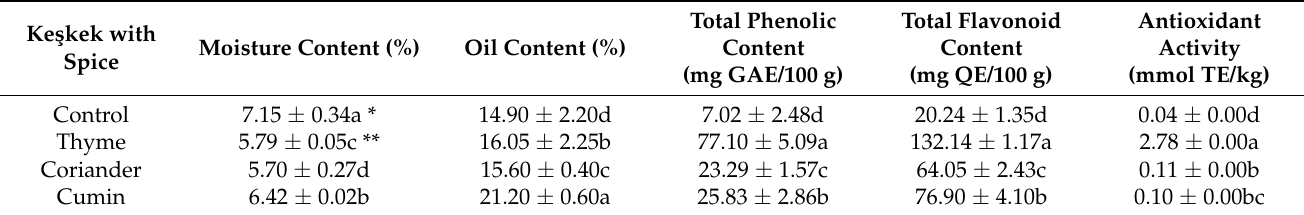
Table 1. Some chemical and bioactive properties of “Ke¸skek”